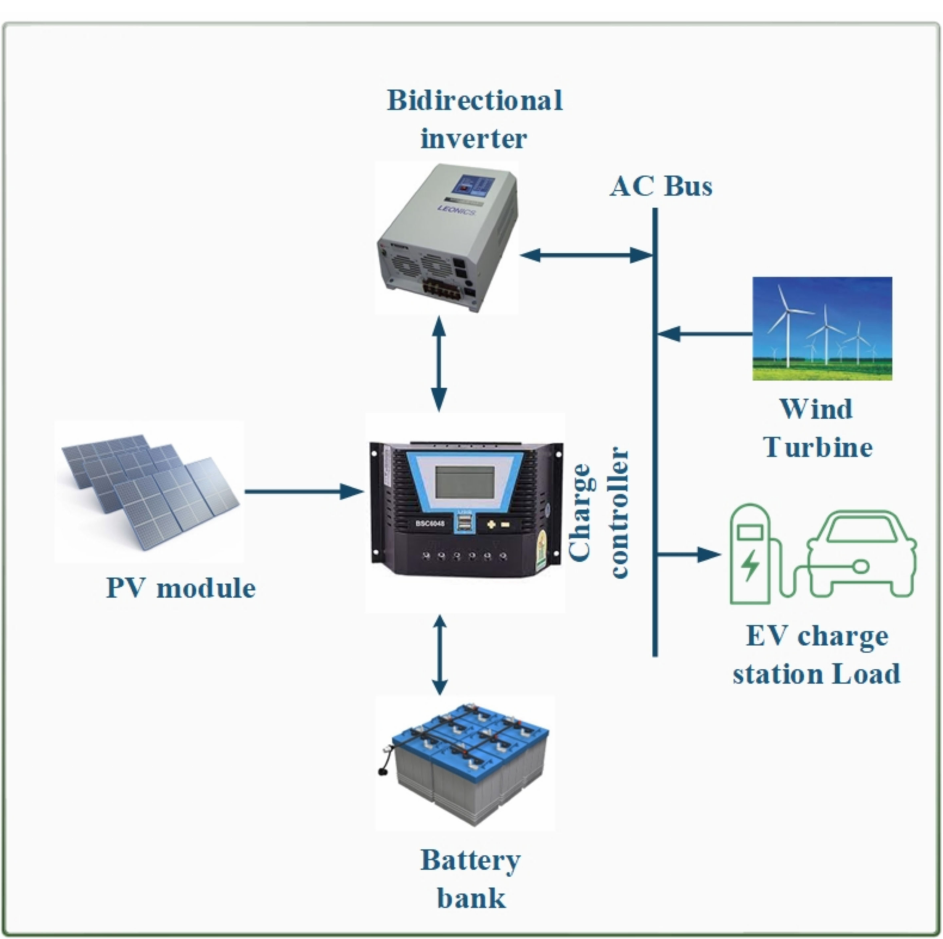
Figure 2. A schematic diagram of the proposed system.